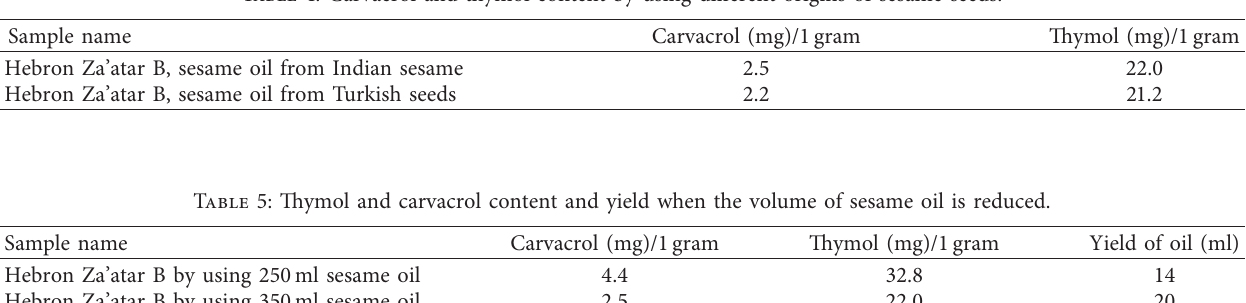
Table 4: Carvacrol and thymol content by using different origins of sesame seeds.